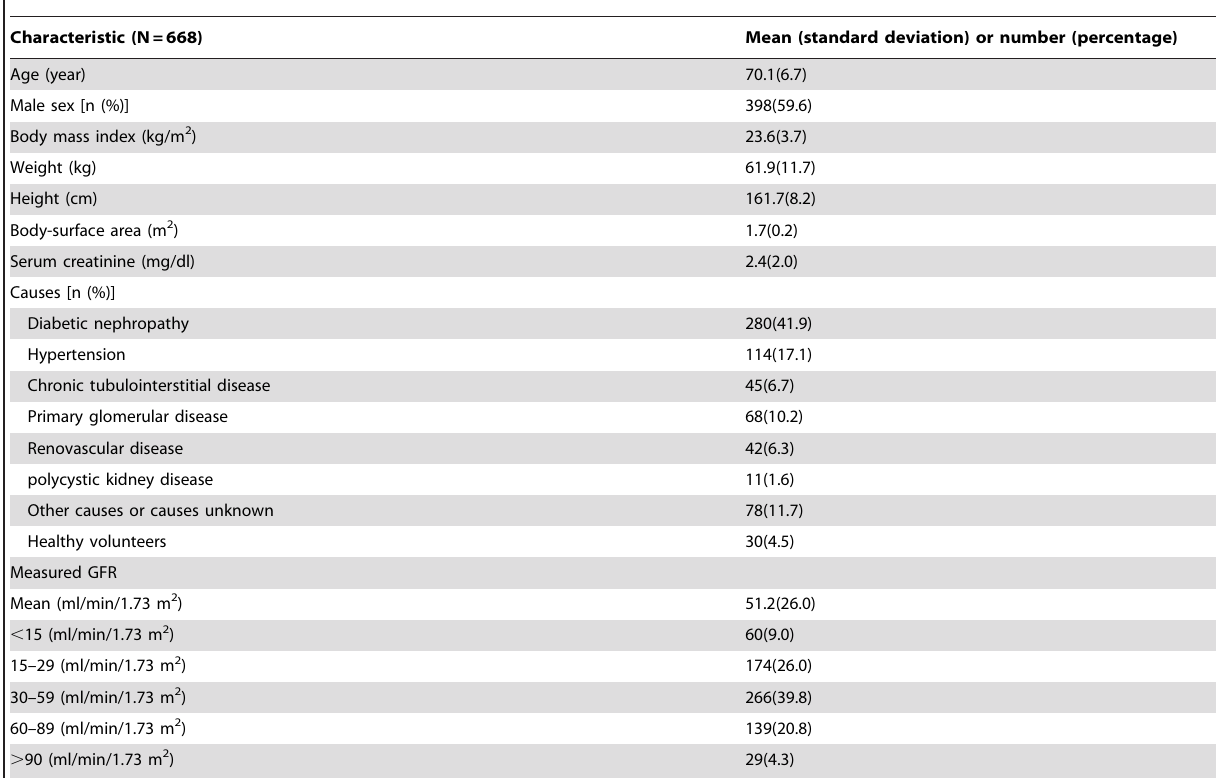
Table 1. Participant